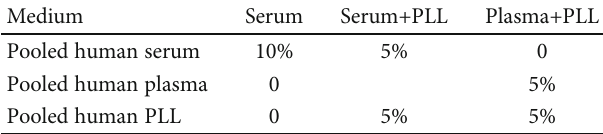
Table 1: Composition of GMP-compliant MSC expansion